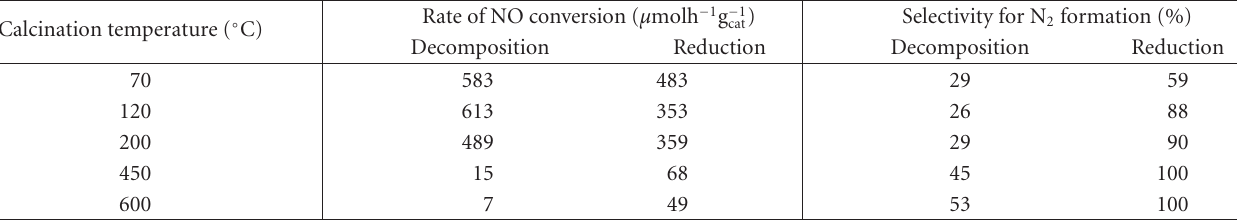
Table 5: Rate of NO conversion and selectivity for N 2 formation for 1wt.% Ag-TiO 2 photocatalysts at various calcination temperatures under decomposition and reduction